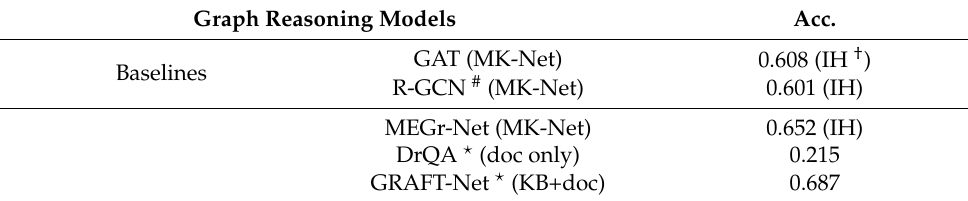
Table 4. Results on Control Group #2.